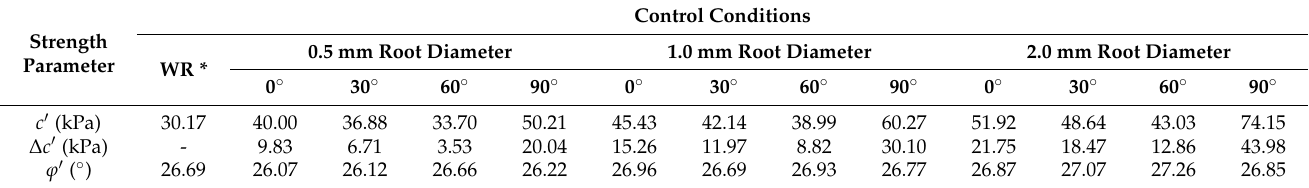
Table 3. Strength parameters of unreinforced soils and root-soil composites.